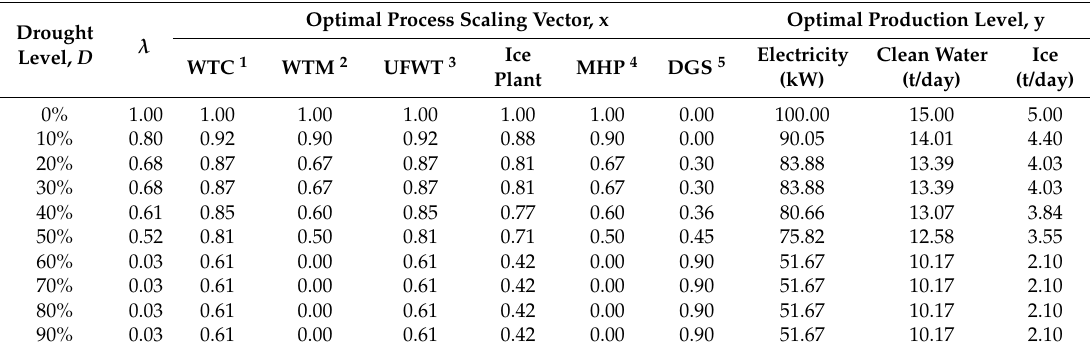
Table 4. The balanced process matrix of case study 2.